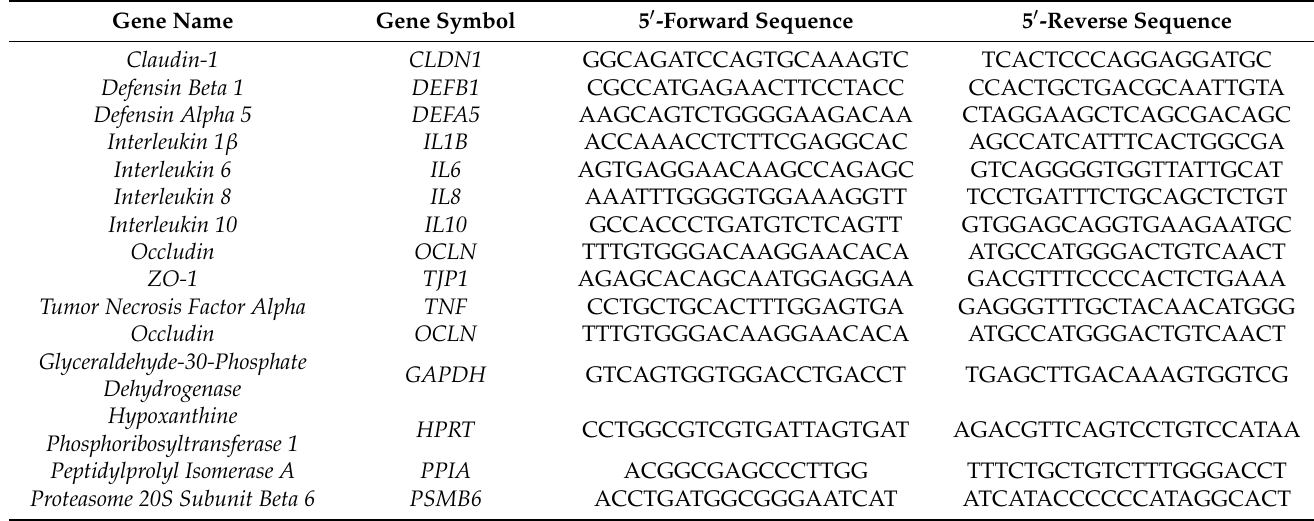
Table 2. Primer sequences for qPCR